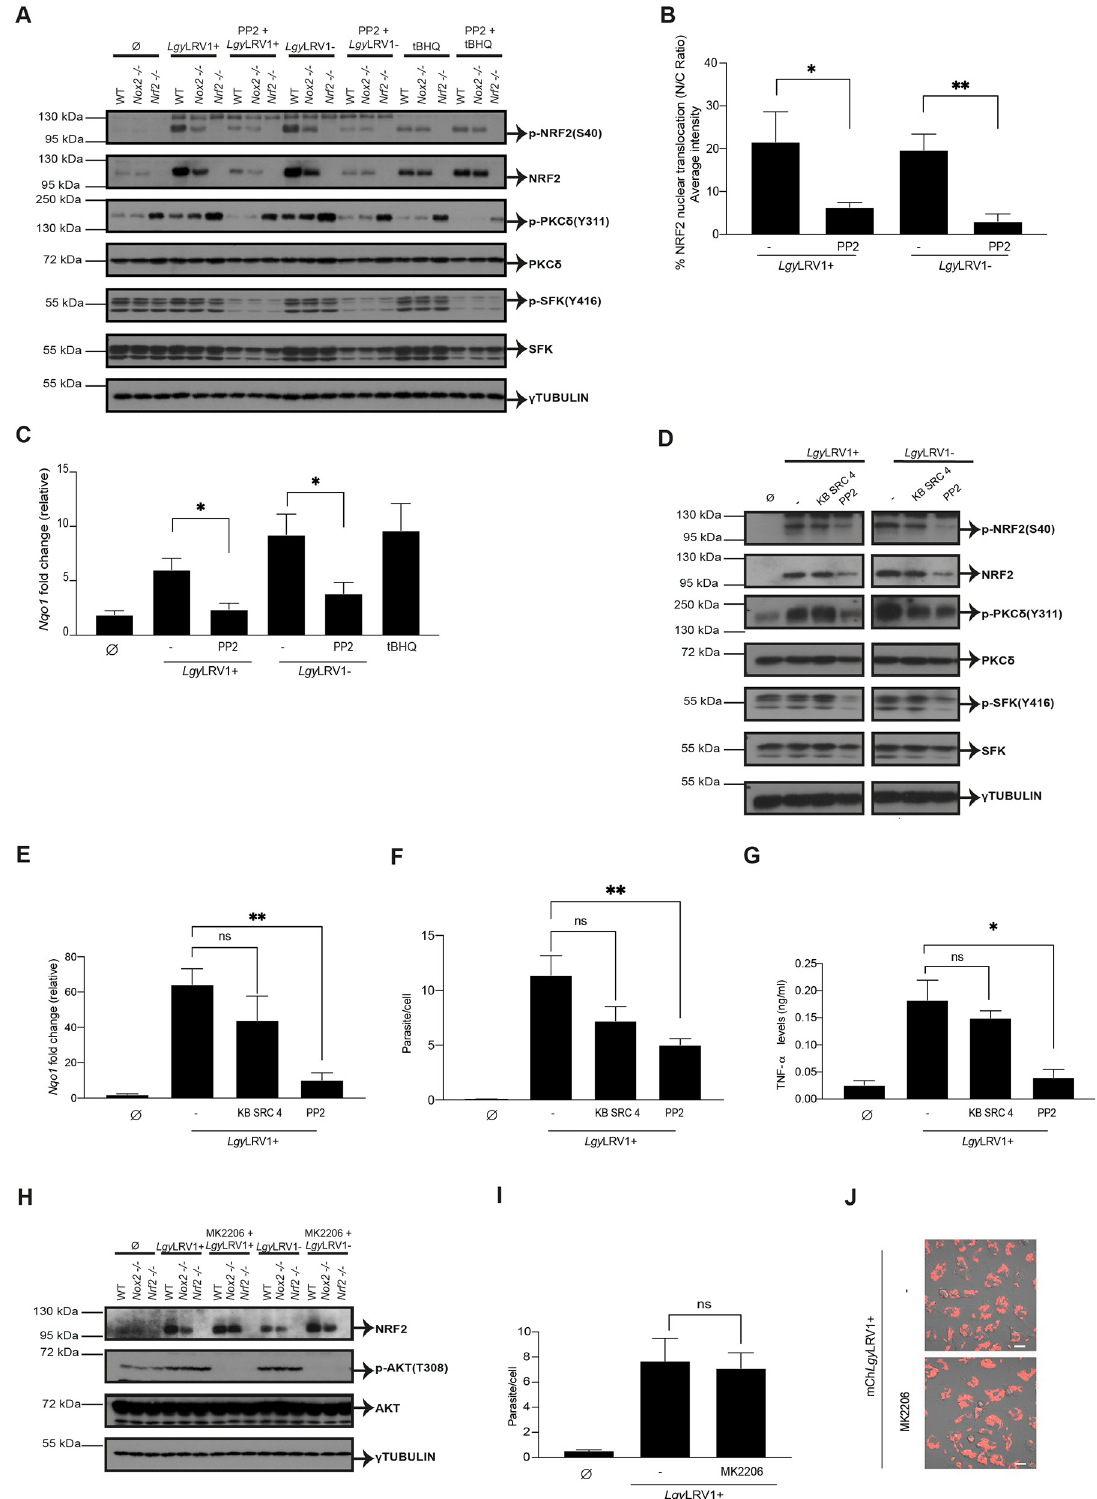
Fig 7. Leishmania activates the host cell NRF2 pathway through an SRC family kinase signaling cascade. A-C) WT, Nox2 -/- or Nrf2 -/- cells were pretreated with DMSO or PP2 (100 μ M) for 1 hr and infected with Lgy LRV1+ or Lgy LRV1- parasites. Non-treated ( Ø ) or tBHQ-treated (10 μ M) cells were performed concurrently. A) Cell lysates after 4 hrs post-infection were analyzed by Western Blot